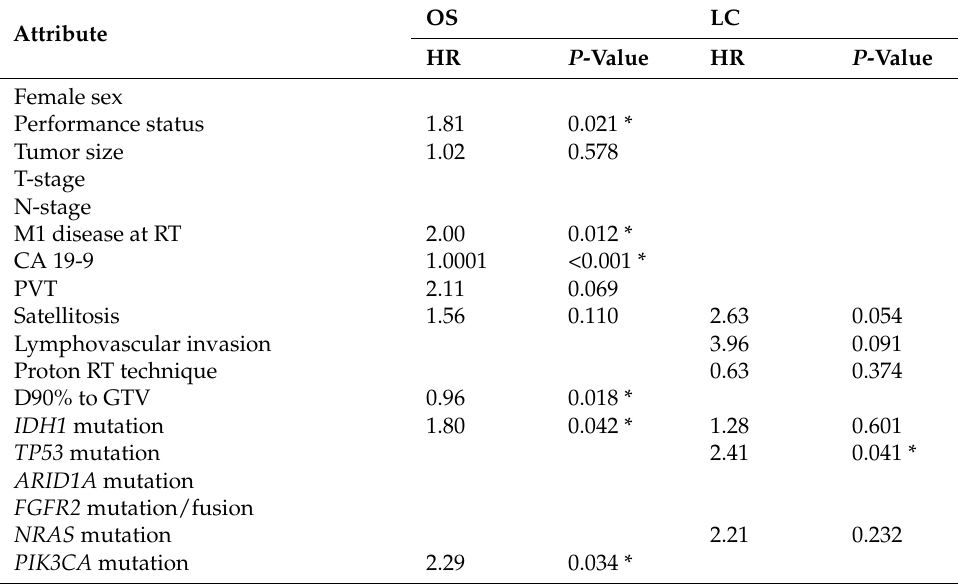
Table 4. Multivariable Cox analysis of factors associated with overall survival and local control following initiation of ablative radiotherapy. Cells corresponding to variables that did not meet criteria for inclusion in the multivariable model are left